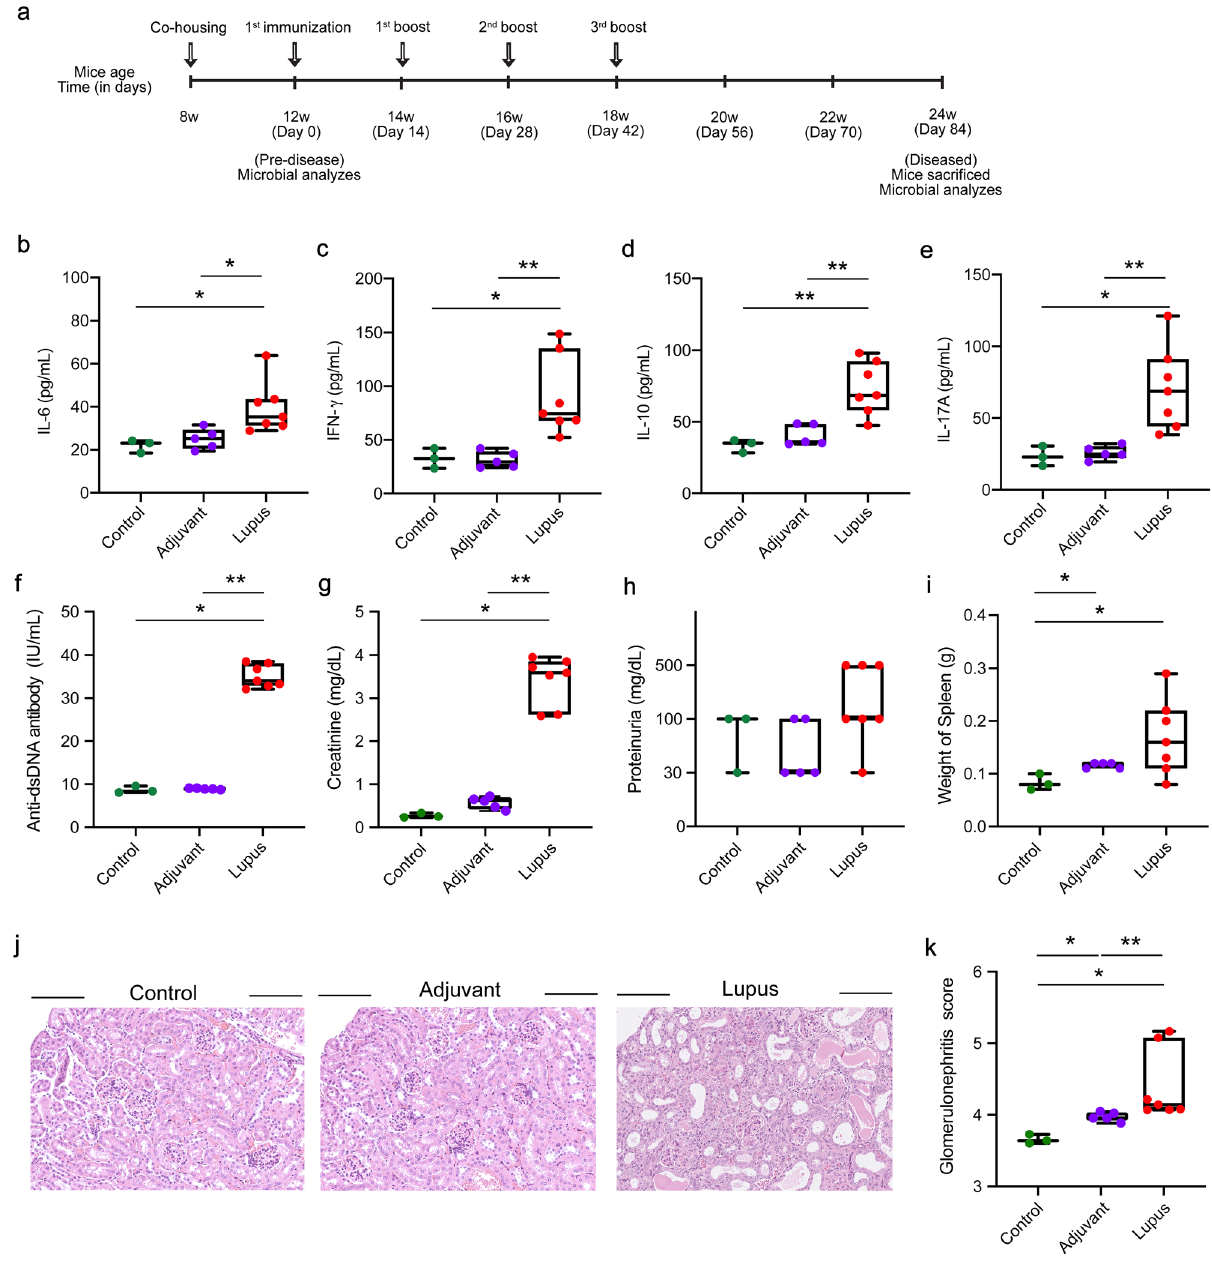
Figure 1. Induction of lupus-like effects in NZB/W F1 mice. Mice were intraperitoneally injected with HCMVpp65 422-439 peptide, adjuvant, or PBS only. ( a ) Schematic of the experiment. Serum ( b ) IL-6, ( c ) IFN-γ, ( d ) IL-10, and (e) IL-17A levels in the lupus (n = 7), adjuvant (n = 5), and control (n = 3) groups at 12 weeks post immunization (24 weeks of age). The levels of ( f ) anti-dsDNA antibody ( g ) serum creatinine, and ( h ) proteinuria in blood and urine from the control, adjuvant, and lupus groups at 12 weeks post-immunization. ( i ) Representative photograph and diagram of spleen size. Data are means ± SEM. ( j ) Hematoxylin and eosin staining of glomeruli from the control, adjuvant, and lupus groups. ( k ) Glomerulonephritis score of renal lesions. Data are means ± SEM of three independent experiments. * P < 0.05 and ** P < 0.01. Full images are shown in Supplementary Fig.